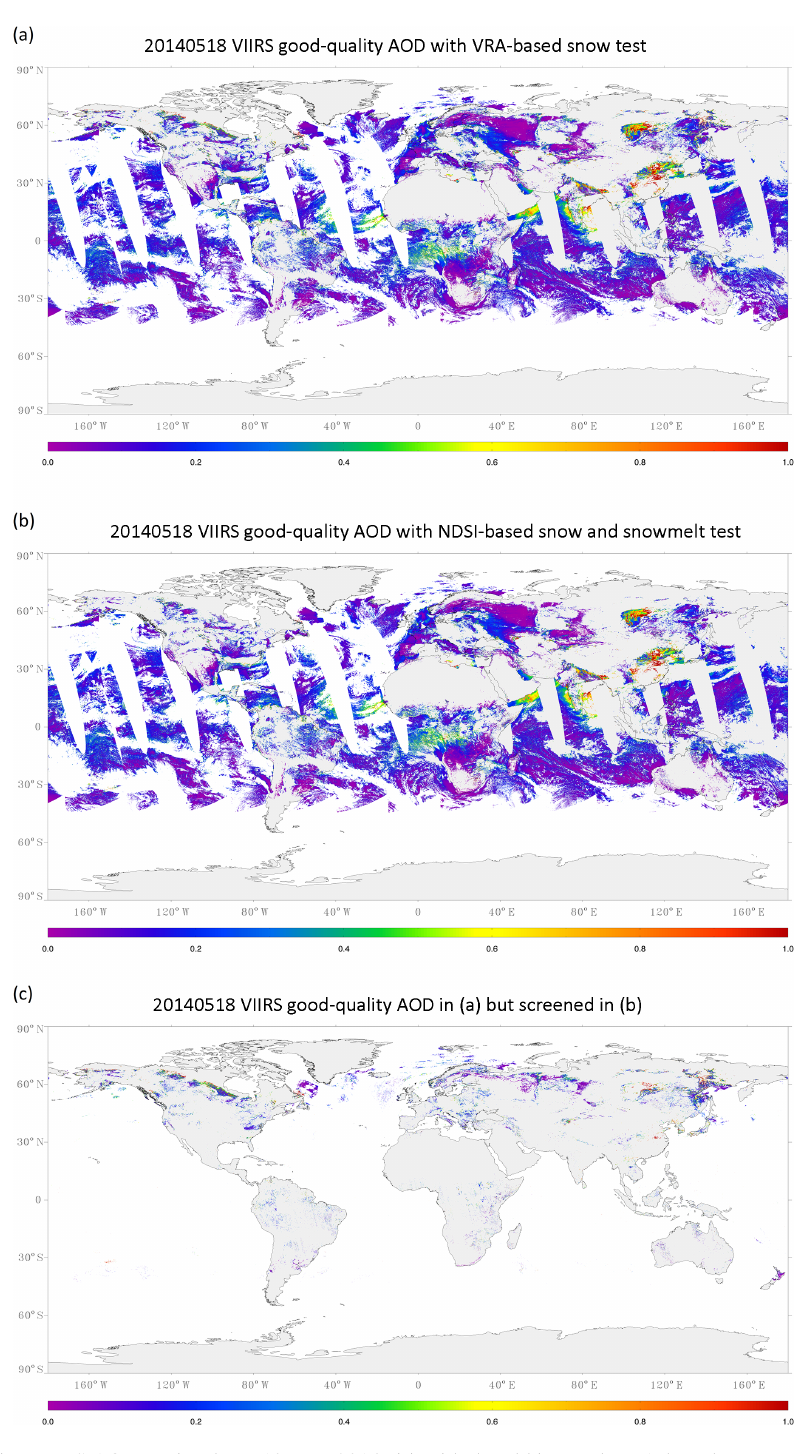
Figure 4. The good-quality VIIRS AOD retrievals on 18 May 2014: (a) with the old internal VRA-based snow test; (b) with the new NDSI- based snow and snowmelt screening scheme; and (c) the difference between (b) and (a) that either were removed because of the new snow test or were degraded by the new snow adjacency test and the spatial homogeneity